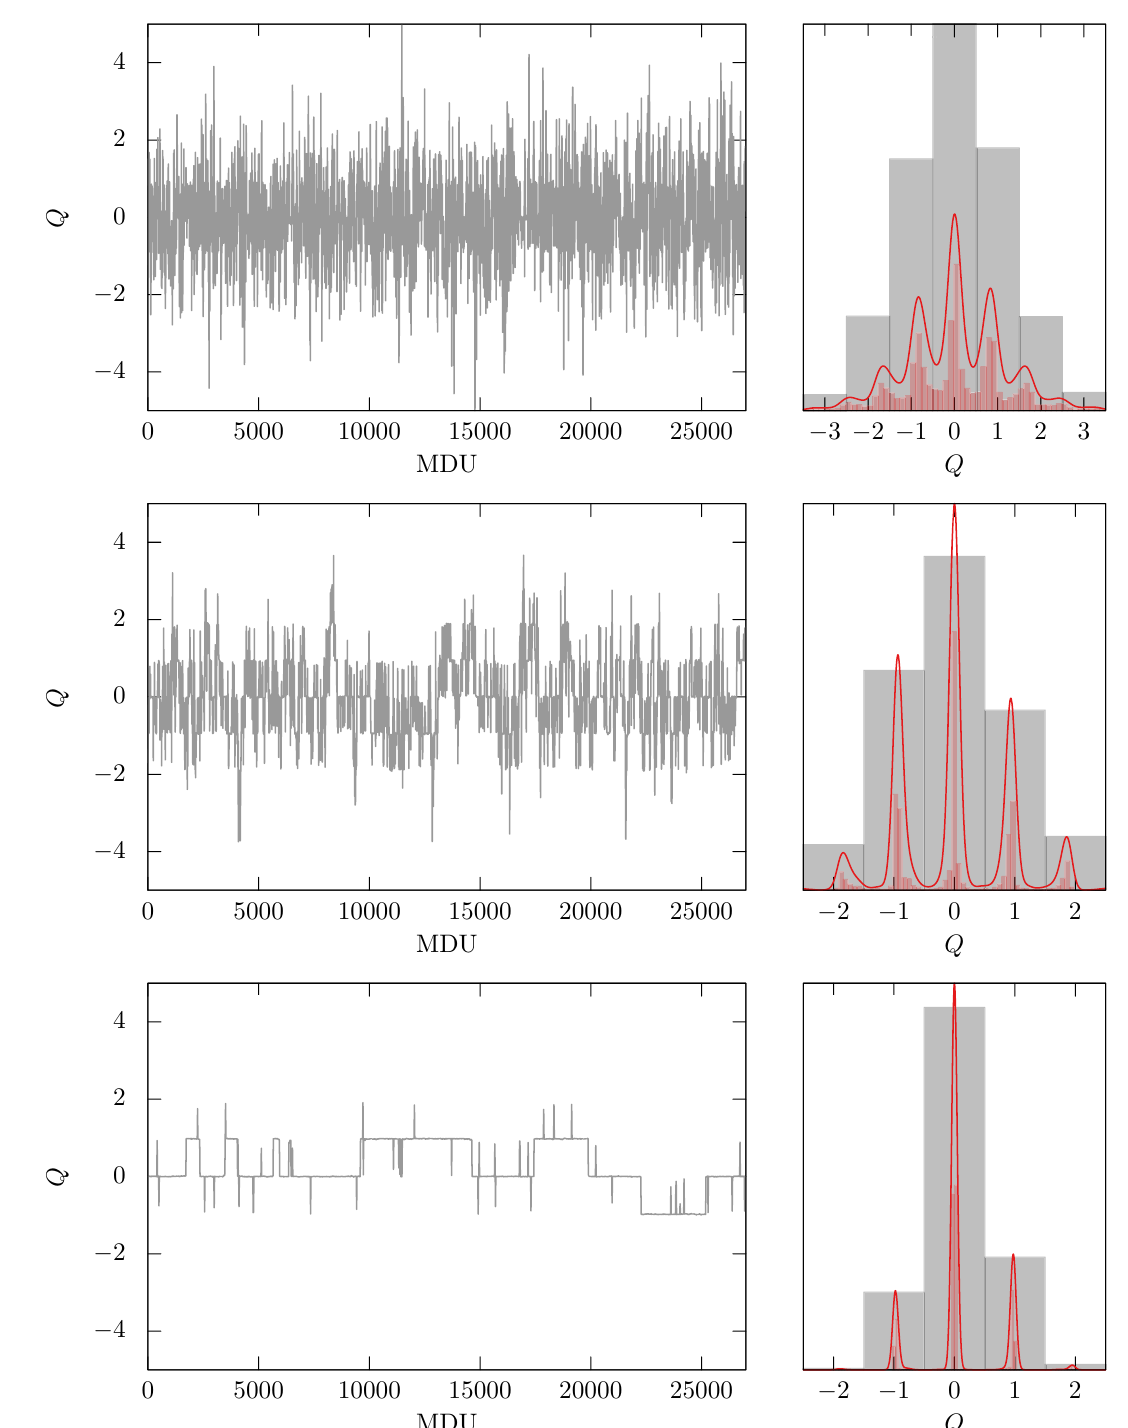
Fig. 1 Topology freezing, monitored through Monte Carlo histories and distributions of the topological charge Q for decreasing lattice spacing (top to bottom: ensembles A1k4, B1k4 and D1k4). The grey histogram counts appearances of Q belonging to different integer sec-